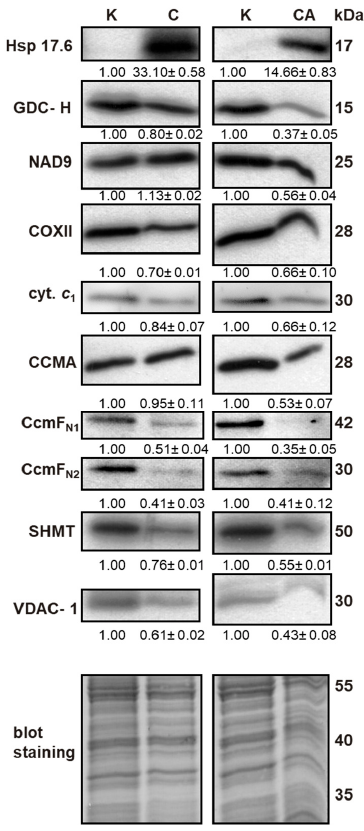
Figure 4. Immunoblotting of proteins from control grown plants ( K ), cold-stressed plants ( C ) and from cold-recovered plants ( CA ). About 10 µg of mitochondrial proteins from cauliflower curds were loaded onto SDS-polyacrylamide gels. Proteins were transferred onto an Immobilone membrane using a semidry system. All assays were performed using specific primary antibodies raised against heat shock protein 17.6C class I (Hsp17.6), glycine decarboxylase subunit H (GDC-H), NADH dehydrogenase (CI) subunit 9 (NAD9), cyt. c oxidase (CIV) subunit 2 (COXII), cyt. c 1 , cyt. c maturation proteins (CCMA, CcmF N1 , CcmF N2 ), serine hydroxymethyltransferase 1 (SHMT) and voltage-dependent